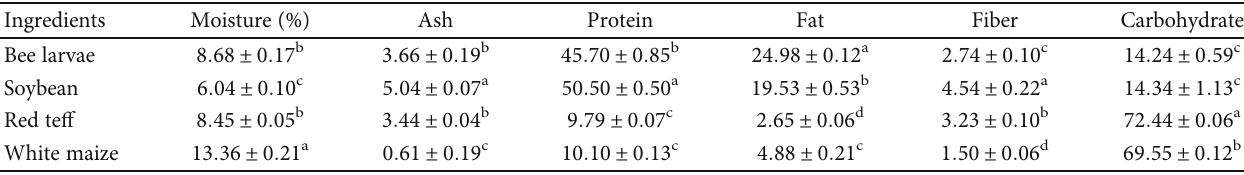
Table 1: Proximate composition of individual food ingredients (g/100 g, dried weight basis). Ingredients Moisture (%) Ash Protein Fat Fiber